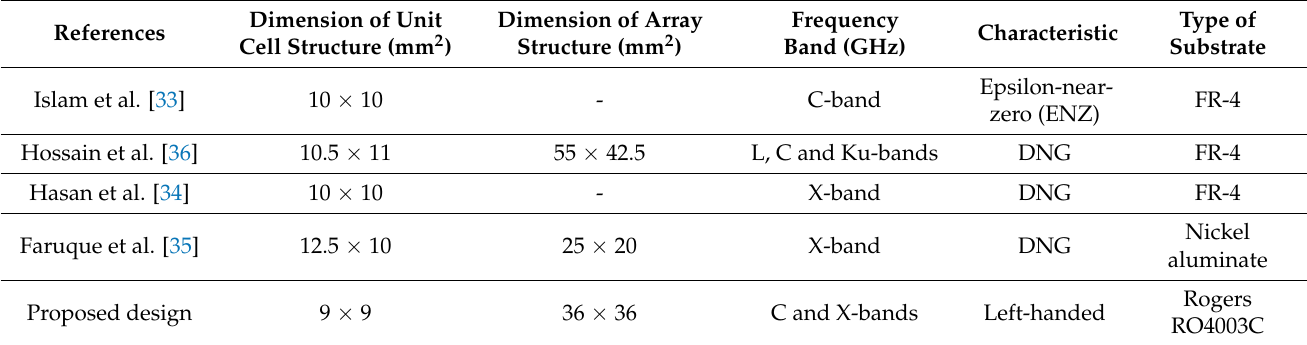
Table 4. The comparison between the proposed design and the previous